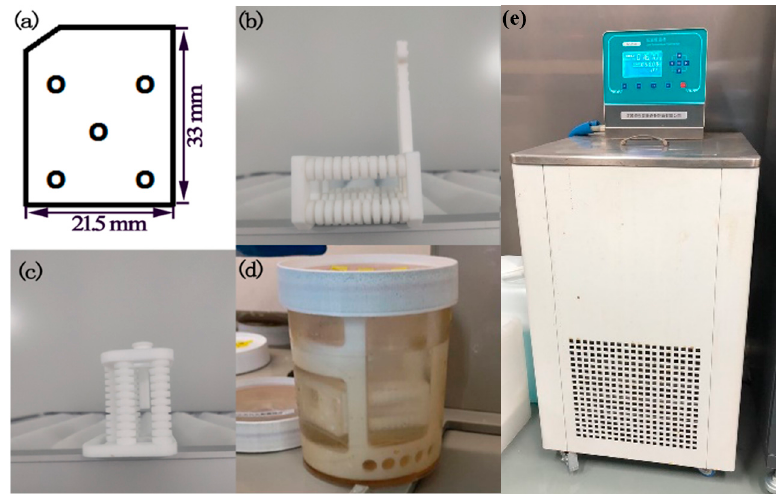
Figure 1. Etching wafers, fixtures, and equipment: ( a ) one-inch wafer and measurement points; ( b ) vertical jig; ( c ) horizontal jig; ( d ) etching tank; ( e ) thermostat tank. The aqueous etching solution used in this experiment is a BOE (buffered oxide etch) solution with a volume ratio of 1:6 (49% HF aqueous solution: 40% NH4F aqueous solu- tion), and the anhydrous etching solution is made of dimethyl sulfoxide, surfactant, and